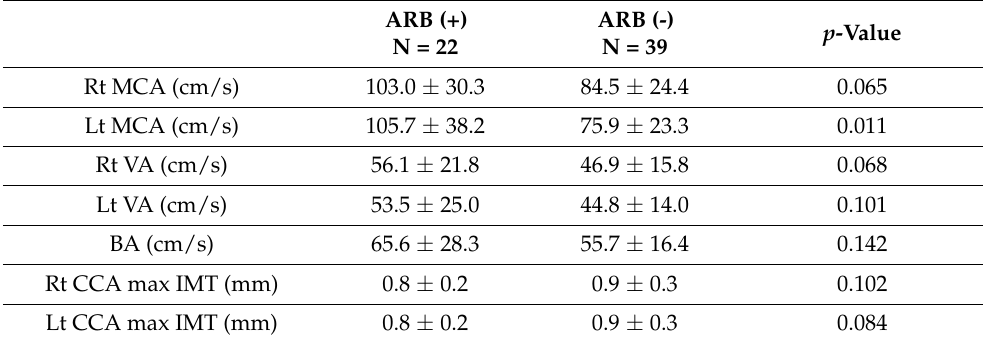
Table 4. ICD measurements (maximal velocity) in HD patients.